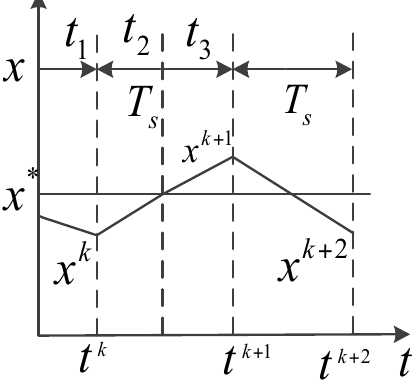
Figure 1. Schematic diagram of one-beat delay .